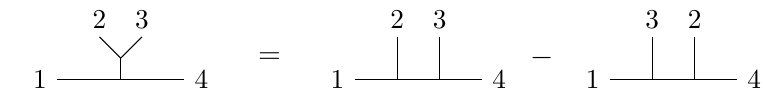
Figure 3 . Example at 4 points of how a diagram relates to master diagrams via Jacobi relations. This equation applies to the colour factors of the diagrams. We shall see that it applies also to their kinematic BCJ